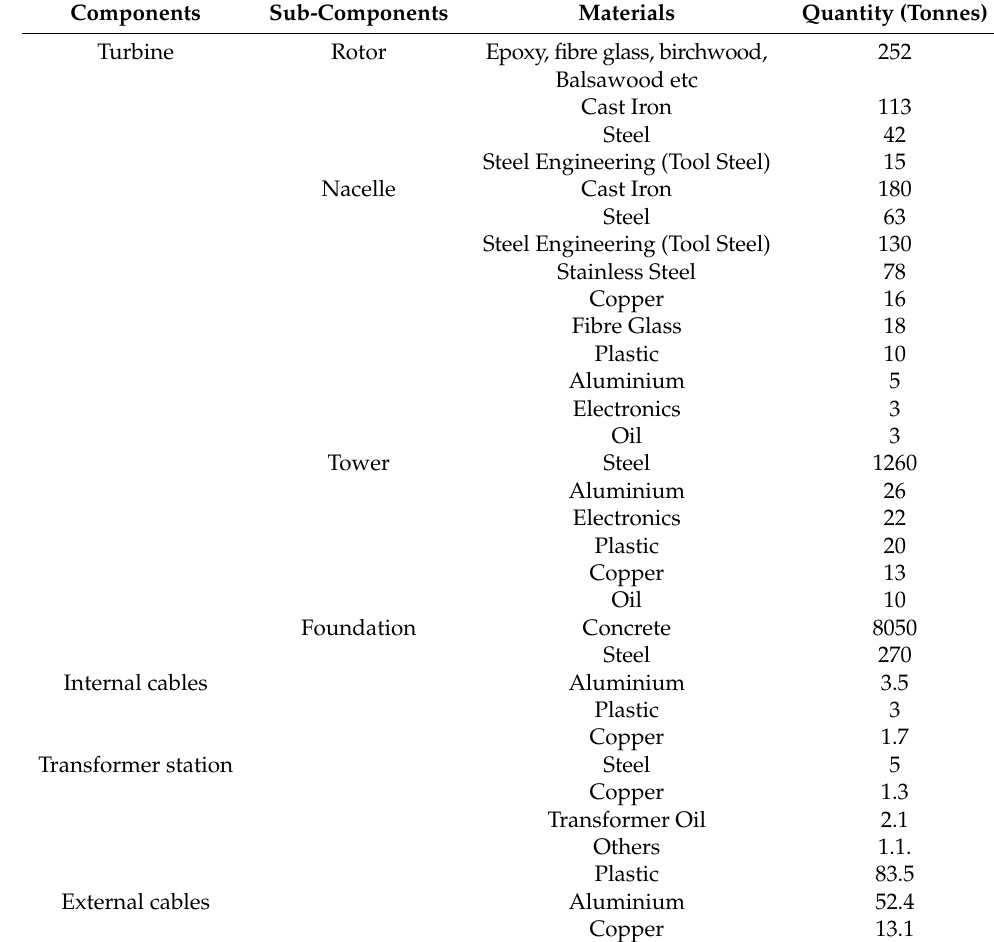
Table 2. LCI data for 10 wind turbines in a wind farm